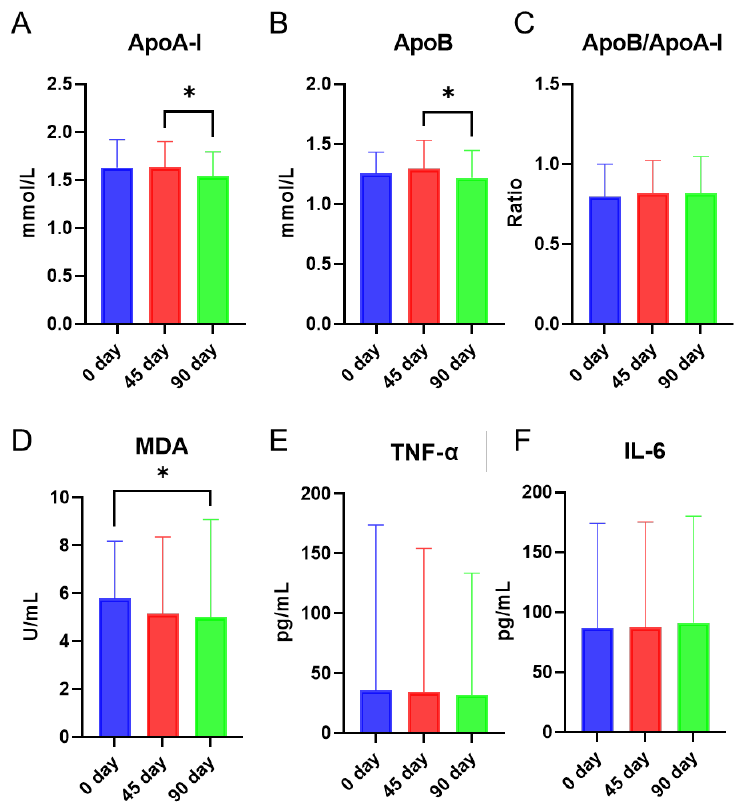
Figure 1. Effects of intervention with sea buckthorn puree on ApoA-I ( A ), ApoB ( B ), Ratio of ApoB/ApoA-I ( C ), malondialdehyde (MDA) ( D ), TNF- α ( E ), and IL-6 ( F ). n = 56, each group. Note: * p < 0.05.